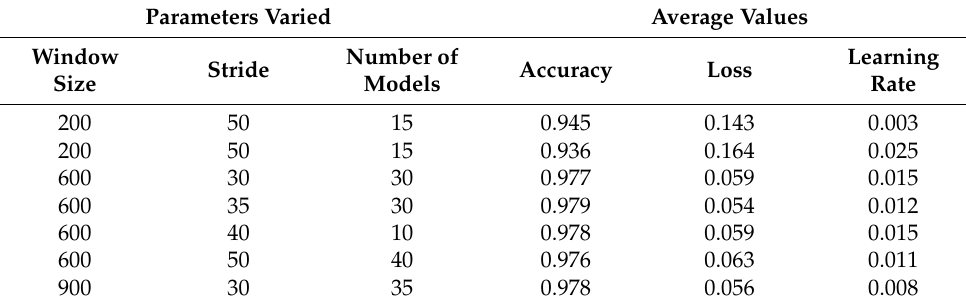
Table 8. Parameters effect on deep learning models